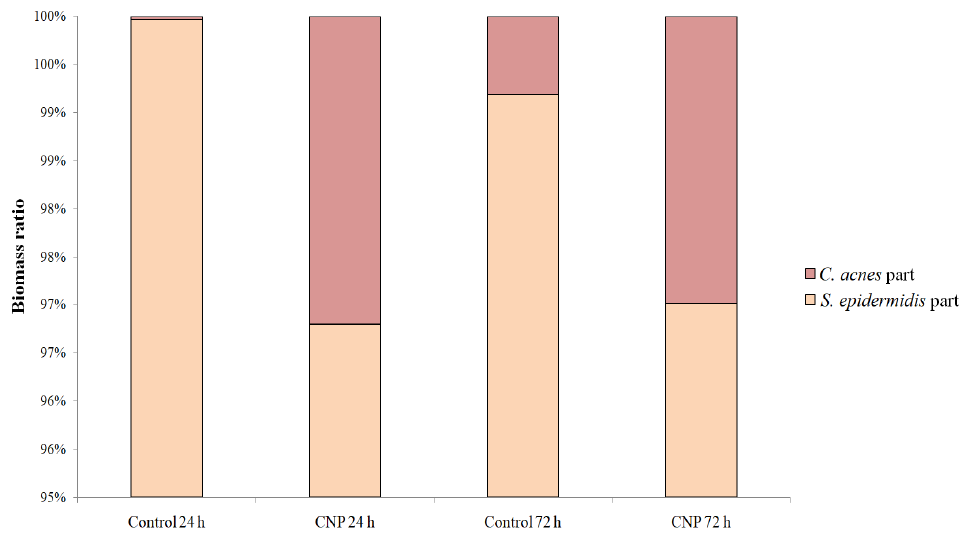
Figure 6. The ratio of S. epidermidis and C. acnes biomass in dual-species communities, analyzed using CLSM.